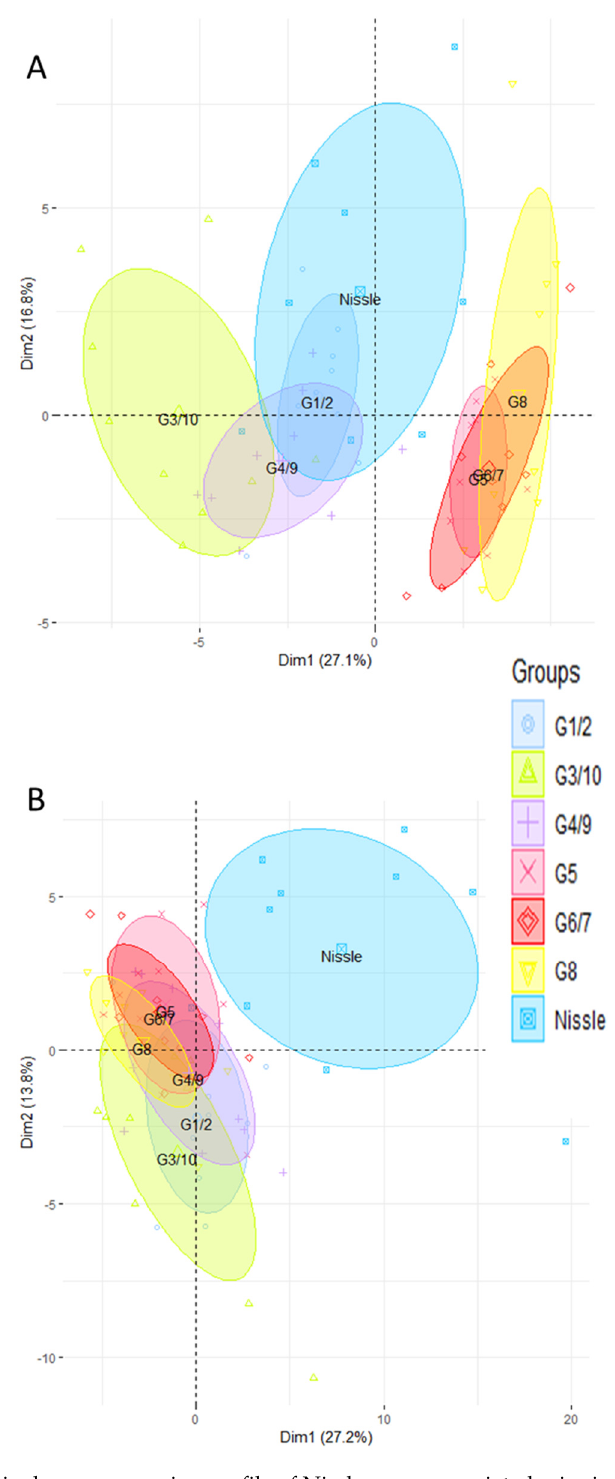
Figure 5. The intestinal gene expression profile of Nissle mono-associated mice is distinct from that of Symbioflor2 ® genotypes mono-associated mice, particularly in the colon. Ileal ( A ) and colonic ( B ) gene expression was analyzed in mice mono-associated with one of the six Symbioflor2 ® genotypes (G1 / 2, G3 / 10, G4 / 9, G5, G6 / 7, G8), or with the Nissle E. coli strain and in GF mice. Rq values that represent the abundance of transcripts relative to GF group were used for PCA analysis after trimming datasets for the least discriminant genes. In total, 49 genes were retained for PCA in the ileum and 79 in the colon; n = 10 for each group of mice.